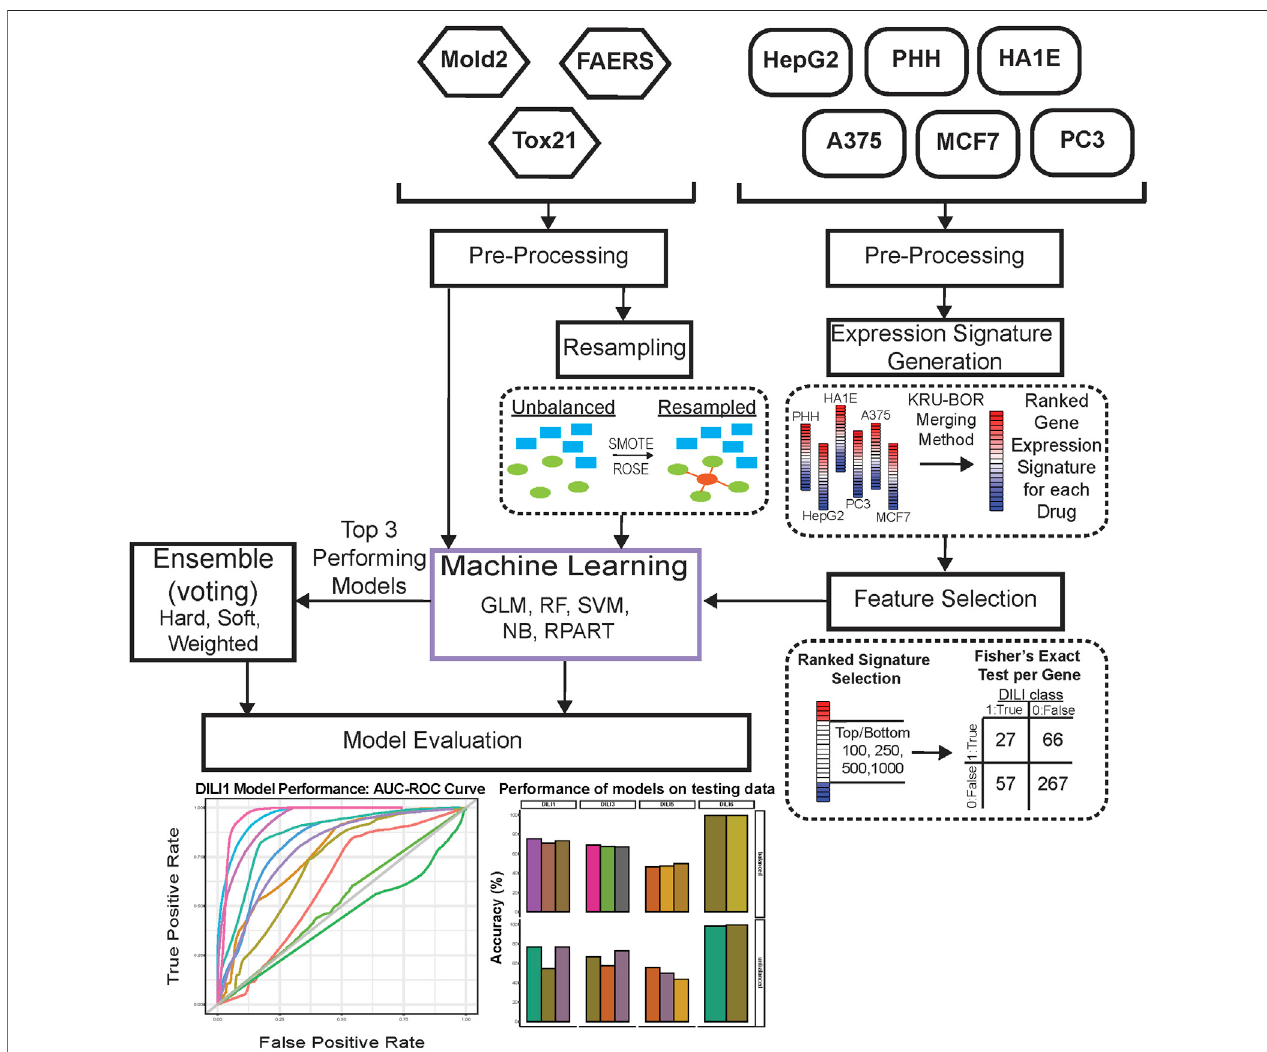
FIGURE 1 | Study Work fl ow. Data were separated into expression-based datasets and non-expression-based (FAERS, MOLD2, TOX21) for testing. Non- expression data was evaluated with resampling methods ROSE and SMOTE as well as an unbalanced dataset. Expression-based datasets were merged across cell linesinto one representative expression signature per drug. These signatures were tested as thetop and bottom 100, 250, 500, and 1,000 ranked genes for each drug. Following signature formation, feature selection using a fi sher ’ s exact test was used to determine signi fi cant predictors of DILI classi fi cation. Machine learning was used on predictors for both expression-based and non-expression models, which were evaluated based on training AUC curve values as well as testing performance. The top three performing models for each DILI type were utilized in ensemble voting models in an effort to incorporate both expression and non-expression datasets.